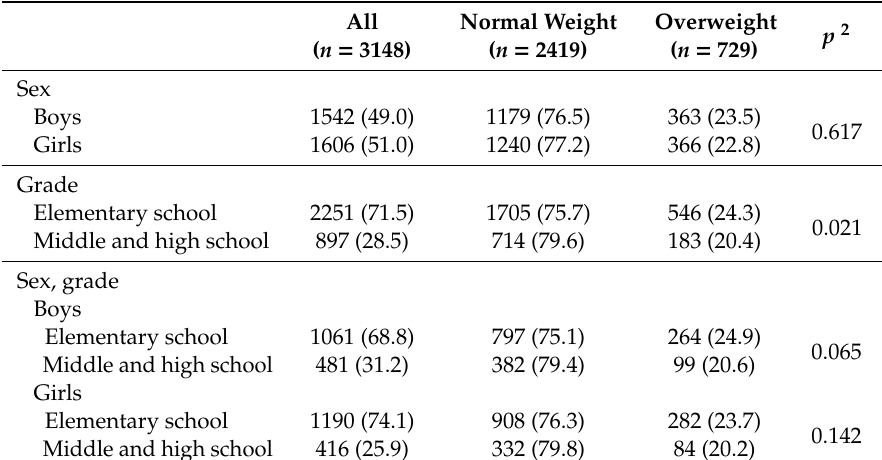
Table 1. General characteristics of subjects 1